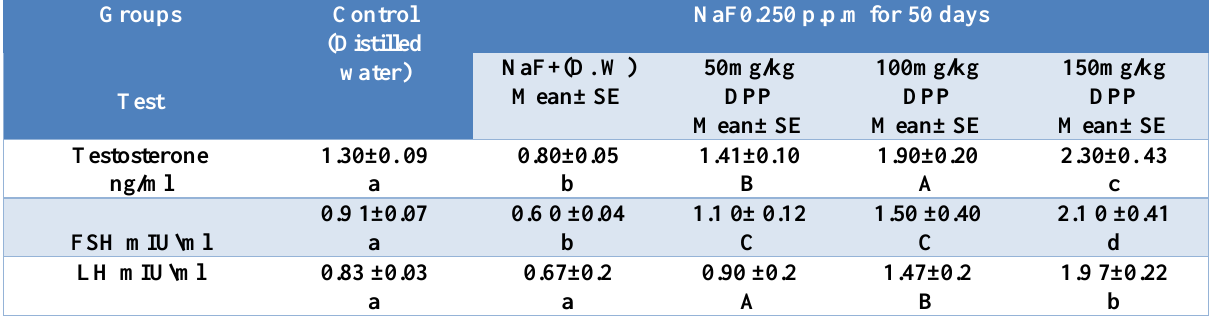
Table, 2: Effect of administration of DPP (50,100,150) mg/kgb.wt on serum testosterone, FSH and LH blood levels in male rats after 50 days treated with NaF (0.250 PPM).